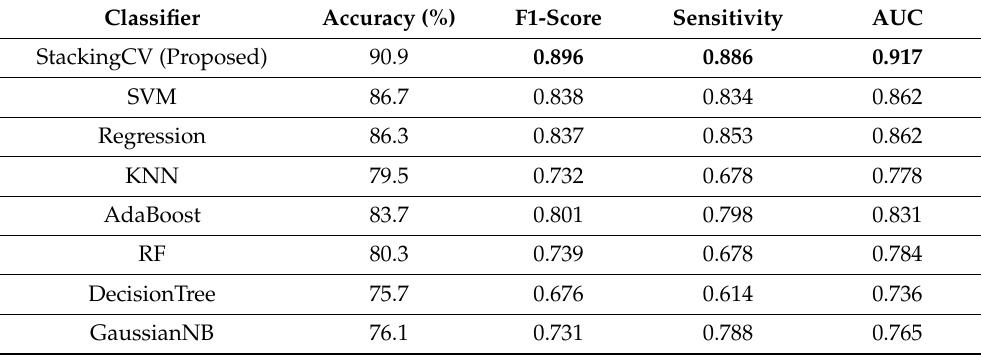
Figure 10. Performance of the system for Xception features.